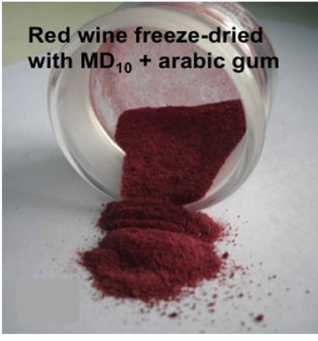
Figure 1. De-alcoholized freeze-dried red wine